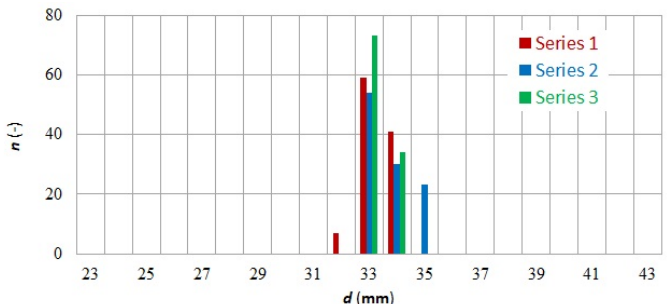
Figure 6. Relationship between the number of thermograms indicated by observers as sharp and the distance d between the element observed and the thermal imaging camera lens.